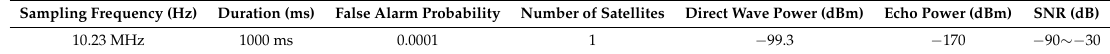
Table 4. Parameter setting of experiment 1.